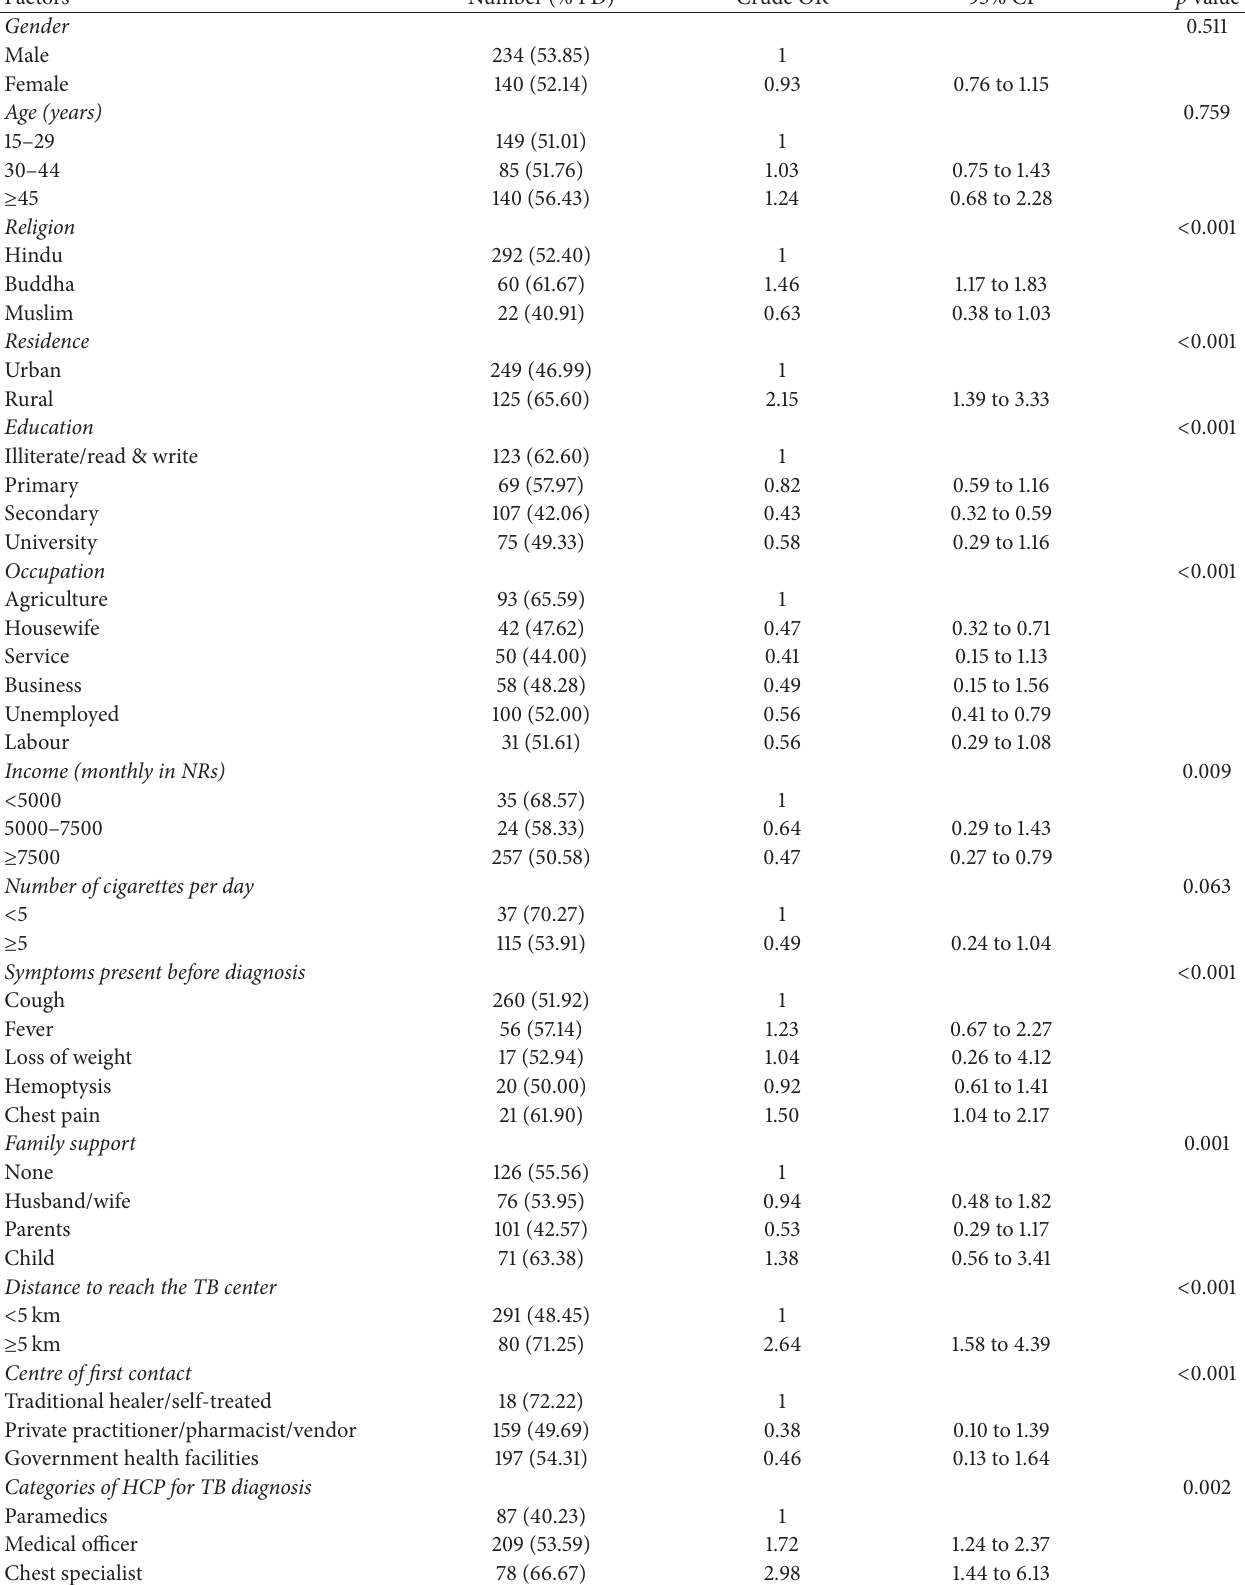
Table 2: Factors associated with patient delay (PD): bivariate